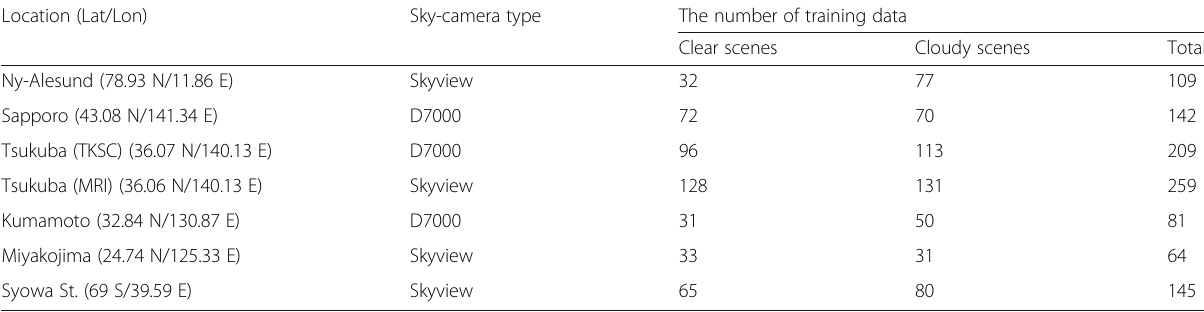
Table 8 Sites and types of sky cameras used for evaluating the CLAUDIA outputs and the amount of training data used for calculating cloud probabilities in SI-BI space for each site